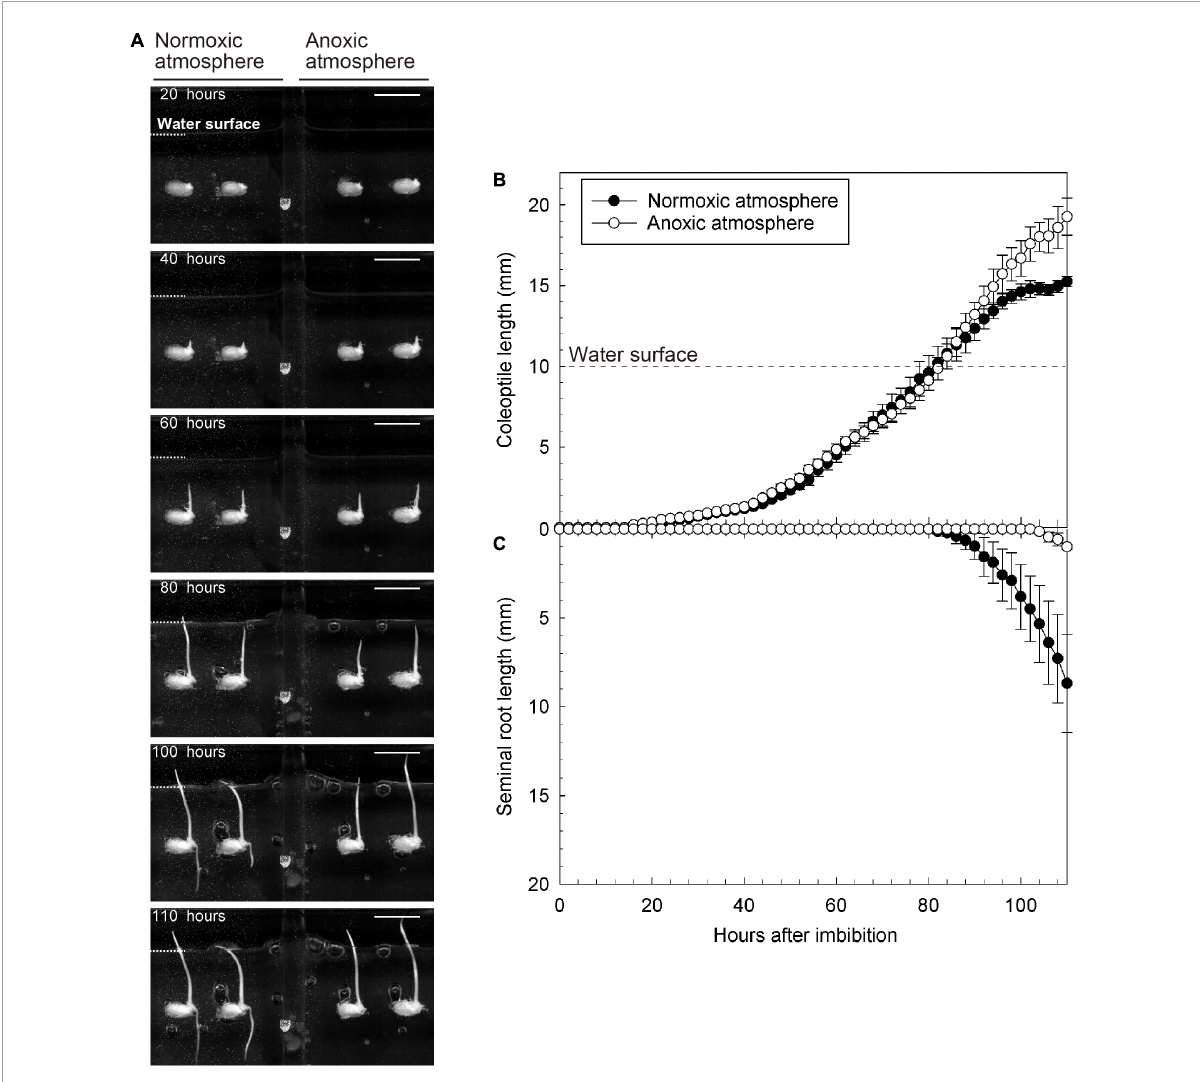
FIGURE2 Growth of coleoptile and seminal root during submerged germination with normoxic or anoxic atmosphere. (A) A sequence of the submerged germination processes. Bars = 10 mm. (B) Coleoptile length, and (C) seminal root length under germination. Means ± SE, n = 4–5. The time lap images of submerged germination are shown in Supplementary Video 1